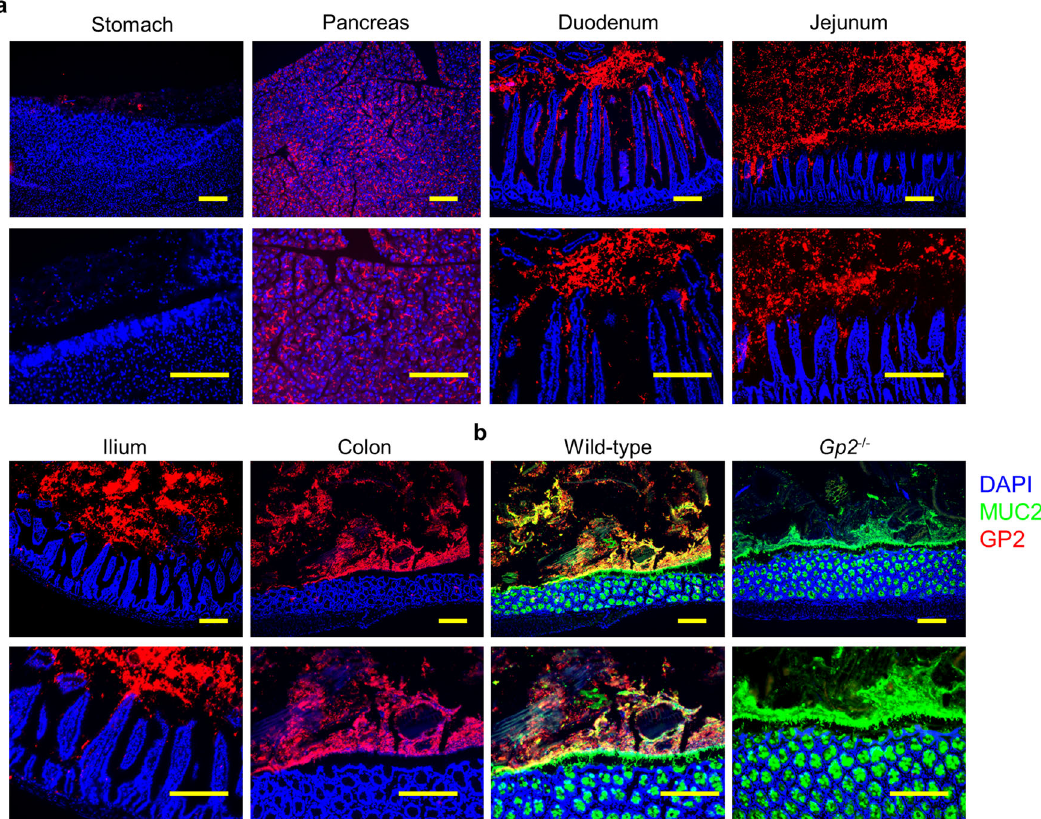
Fig. 1 GP2 in mouse digestive tract. a Immunohistochemical analysis of GP2 distribution in the gastrointestinal tract (stomach, duodenum, jejunum, ileum, and colon) with luminal contents and pancreas of an intact mouse; labels correspond with those shown in. Representative data of fi ve independent experiments are shown. GP2 (red), DAPI (blue). Scale bars, 100 μ m. b Counter staining of mice colon with MUC2 (green) of WT and Gp2-de fi cient mice are shown. Representative data of 3 independent experiments are shown. Scale bars, 100 μ